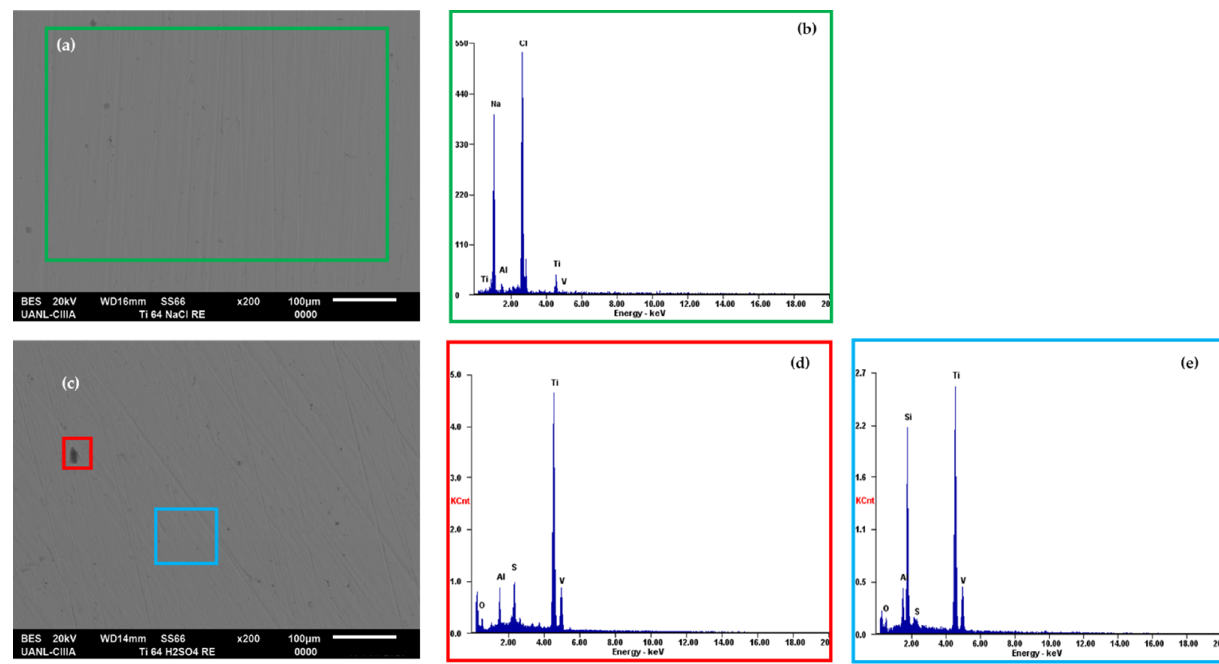
Figure 10. SEM-EDS surface morphology micrographs of Ti-6Al-4Valloys in ( a ) NaCl and ( c ) H 2 SO 4 solution and H 2 SO 4 solution; the rectangles show the areas where EDS analysis was performed for each image; ( b ) NaCl and ( d , e ) H 2 SO 4 .